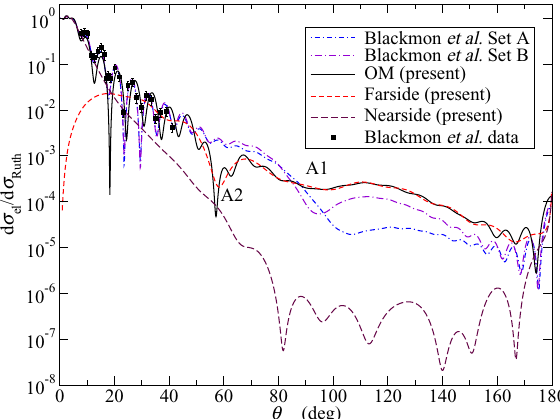
at 170 MeV. The solid squares denote the experimental data ex- tracted from Ref. [15]. The curves represent the results of the OM calculations. The present OM calculated angular distribu- tion is decomposited into the farside and nearside component. The OM calculations with the OPs from Ref. [15] are also plot- ted for